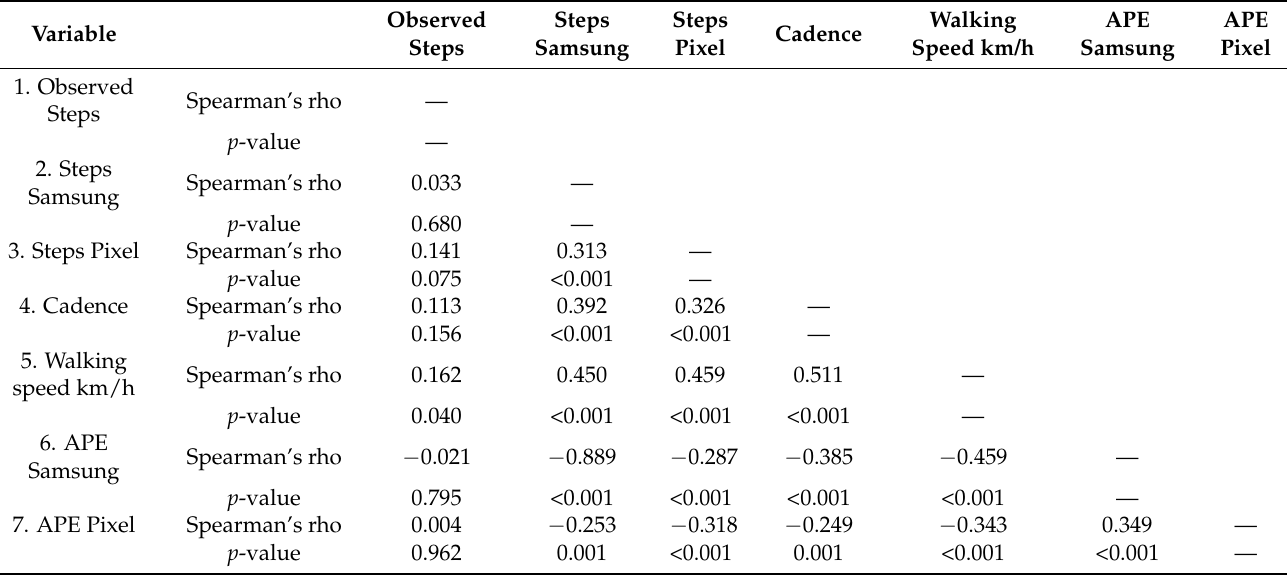
Table 3. Spearman’s rank correlation analysis results showcasing correlations of the study